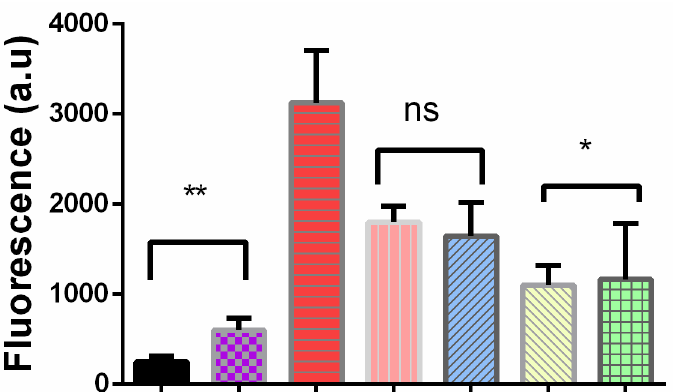
Figure 1. Maleimide cysteine labeling inhibition through covalent interactions of compounds 1 , 2 , 3 . Data were analyzed through one way-ANOVA and Dunnett’s multiple comparison test ( p < 0.05). Non-significant (ns), significant (*), (**). The black, purple, red, pink, blue, yellow, and green bars represent sodium acetate 100 mM; tau: heparin (4:1) plus Tris(2-carboxyethyl) phosphine (TCEP); tau: heparin (1:4) plus Tris(2-carboxyethyl) phosphine (TCEP); DMSO (oxidizing agent); compound 1 ; compound 2 ; compound 3 , respectively. The experiments were done in triplicate.